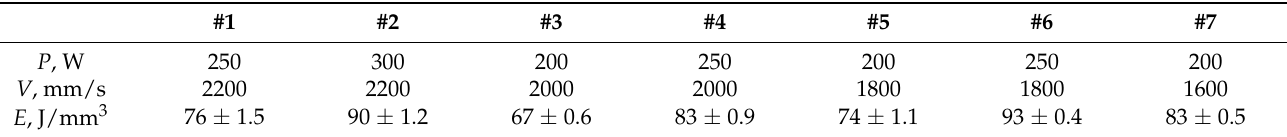
Table 2. Selected parameters of SLM (laser beam power ( P ), velocity ( V ), and energy density ( E ) calculated per Equation